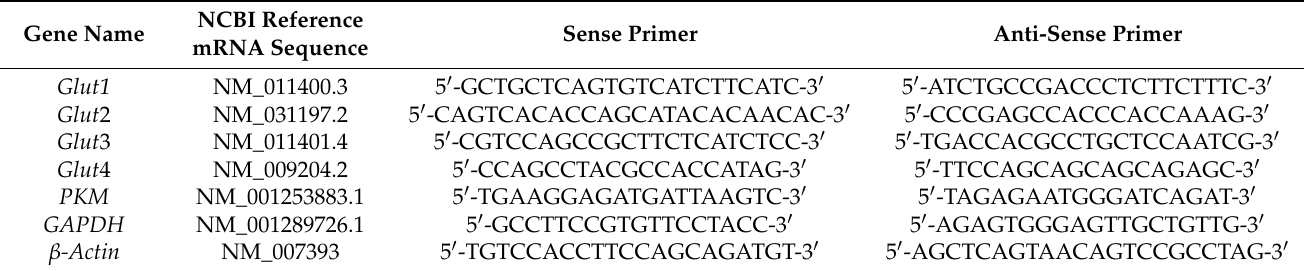
Table 1. Oligonucleotide sequences of the primers used in this study for the amplification of the selected mice